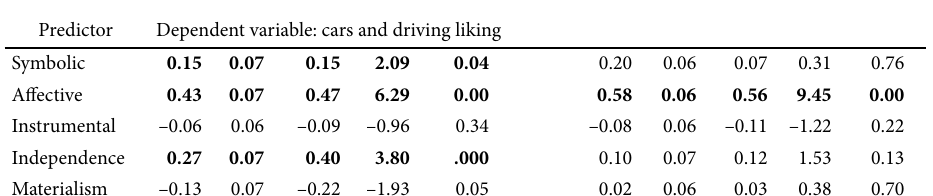
Table 5. Multiple regression of regular driving and cars and driving liking as predicted by motives (sym- bolic, affective, instrumental-reasoned, and independence) and materialist values calculated separately for males and females Males Females β SE B t p –value β SE B t p –value Predictor Dependent variable: regular driving Symbolic Instrumental